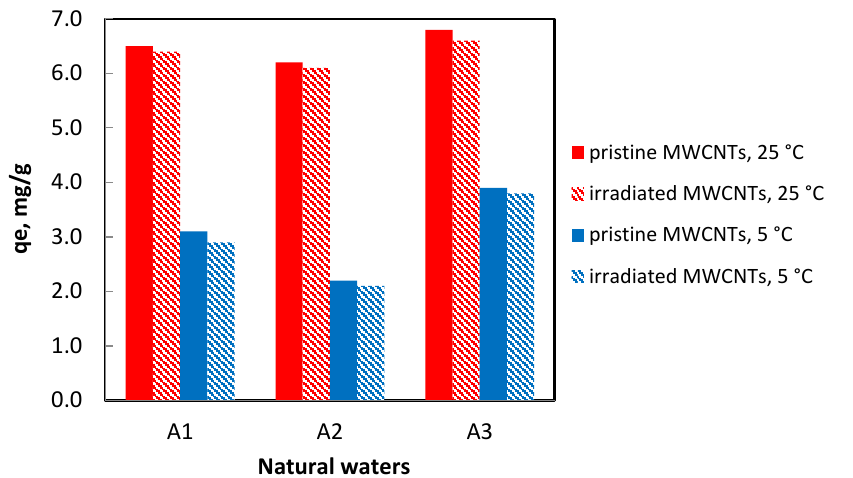
Based on the composition of the natural waters that were used in the adsorption ex- periments (Table 4), the influence of Na + , K + , Ca 2+ , and Mg 2+ cations on the adsorption capacity of TCC on simple and irradiated MWCNTs was analyzed (Figure 5). Figure 4. Equilibrium adsorption capacities of TCC on MWCNTs in natural surface waters A1, A2, and A3 at the two temperatures 5 ◦ C and 25 ◦ C; Conditions: Ci = 100–400 µ g/L TCC, m = 0.1 mg MWCNTs, pH A1 = 7.67; pH A2 = 7.33; pH A3 = 8.21; contact time 4 h.